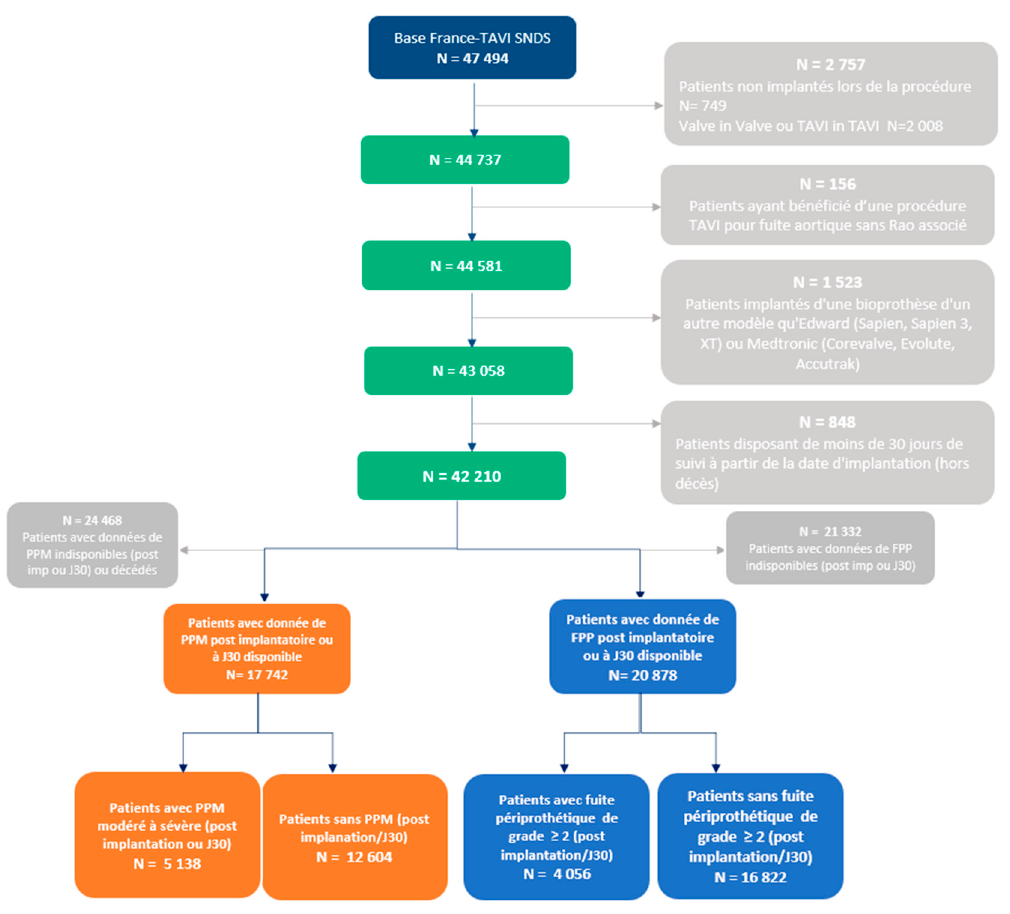
Figure 1. Flow chart.